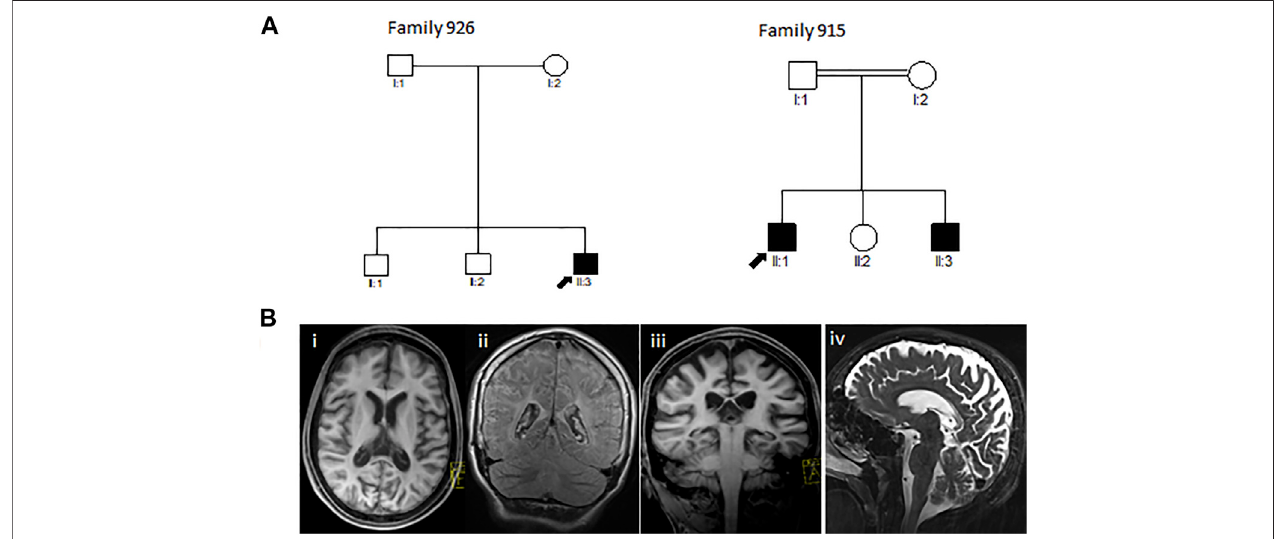
FIGURE 1 | (A) Pedigrees of the reported Greek-Cypriot families (families 926 and 915). (B) Representative axial (i), coronal (ii, iii), and sagittal (iv) T1 and T2- weighted MRI images of the brain of the proband from family 926 aged 16 years demonstrating diffuse hypomyelination, thin corpus callosum, and cerebral and cerebellar